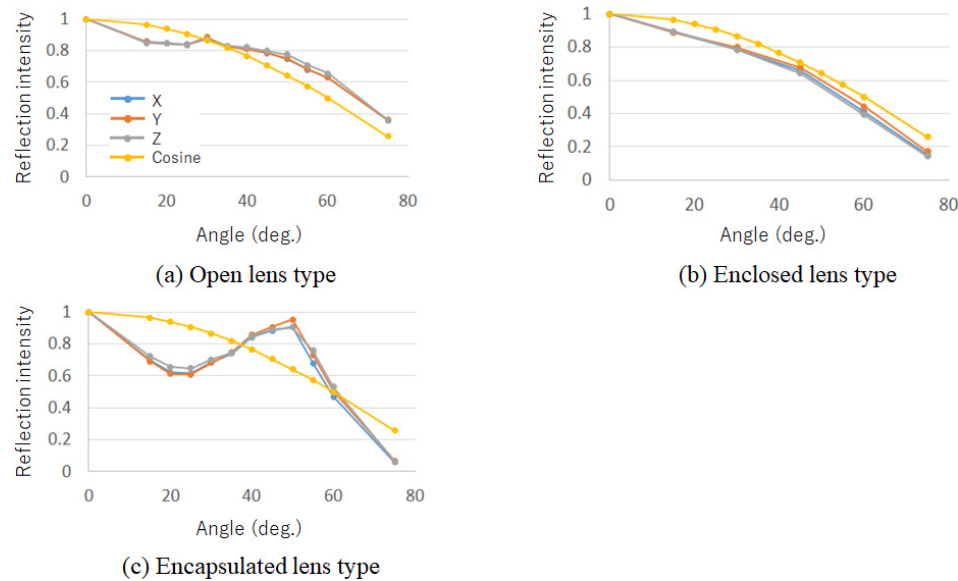
Figure 3. Reflection intensity per angle of rotation. For comparison, the intensity change according to cosine is superimposed.